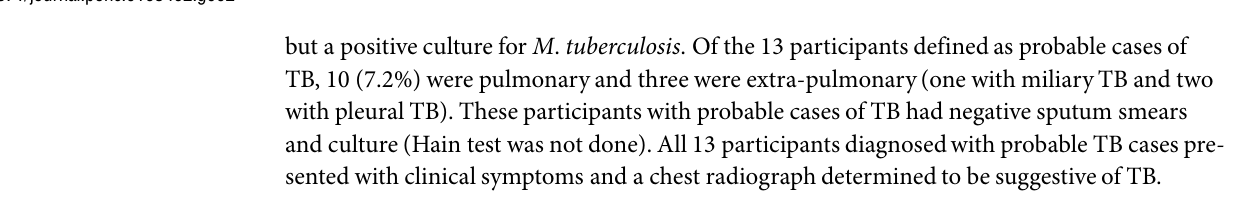
Fig 2. Diagnostic Testing.